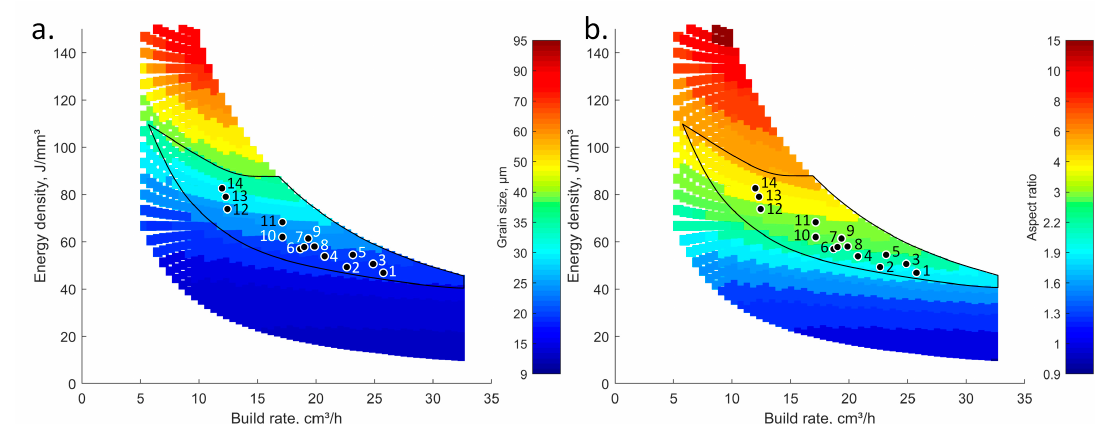
Figure 9. ( a ) Grain size (dxz) and ( b ) grain aspect ratio (GAR) processing maps for iron powder; contours delimit the processing conditions corresponding to a printed density ≥ 99.9%; numbers from 1 to 14 identify processing conditions of the calibration specimens.